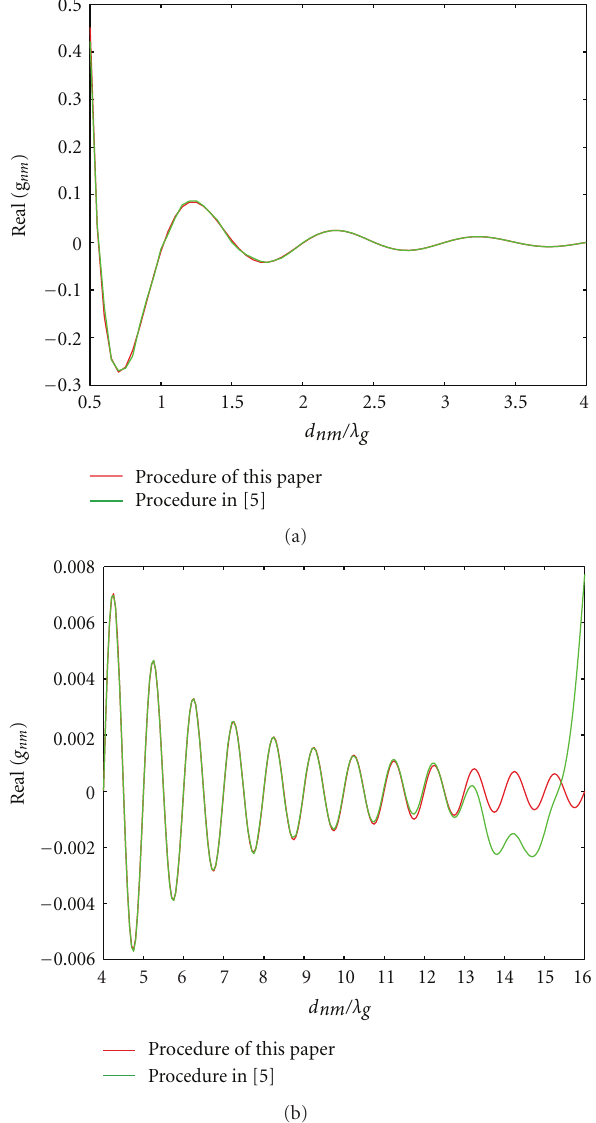
Figure 4: Real part of the mutual coupling coe ffi cient g nm , θ = 0.